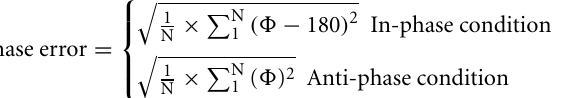
from 30 ◦ flexion to 30 ◦ extension (dashed lines). In some conditions, upper limbs were occluded by opaque boxes, here presented as black rectangles. White arrows indicate the gaze direction toward the right passive wrist (upper row) and left active wrist (lower